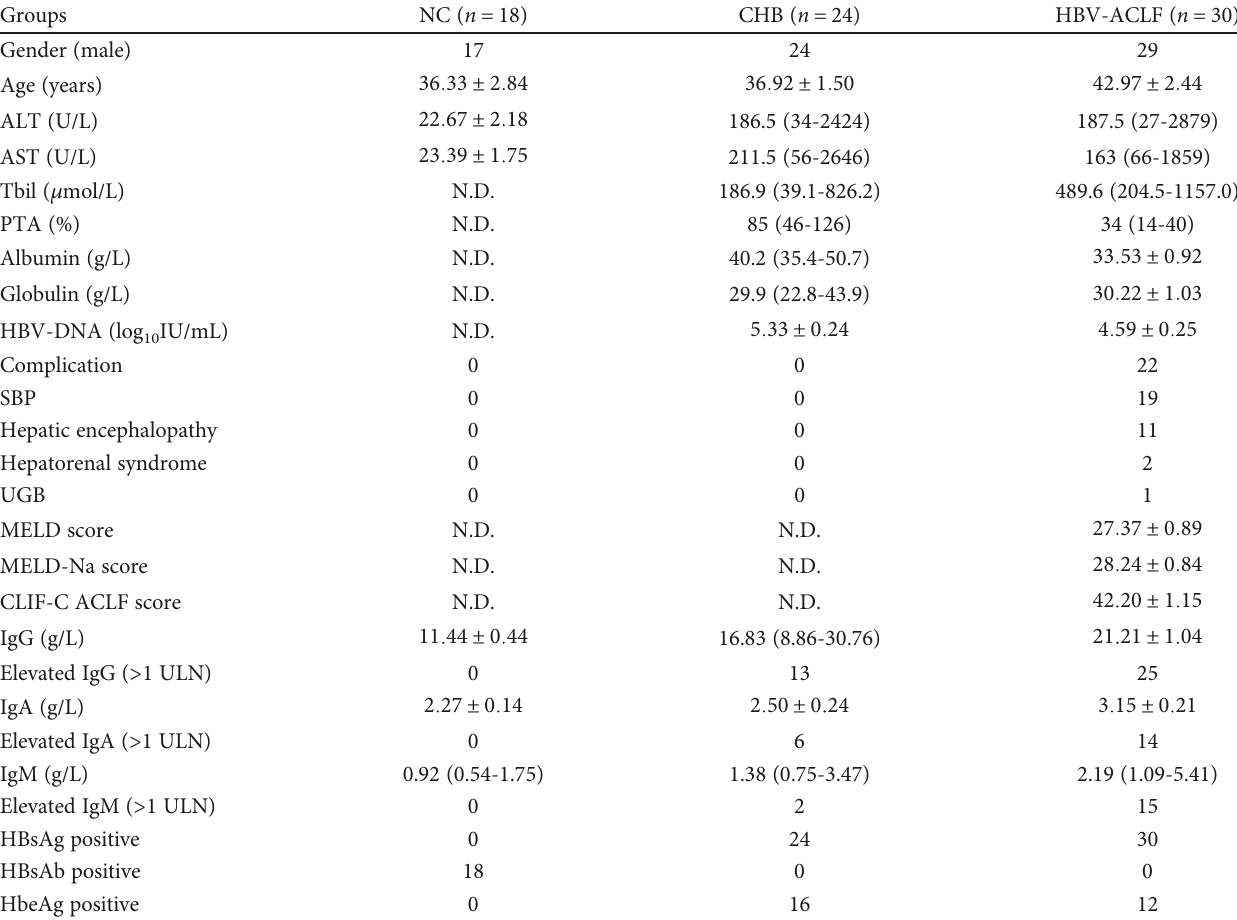
Table 1: Clinical characteristics of the participants enrolled in the